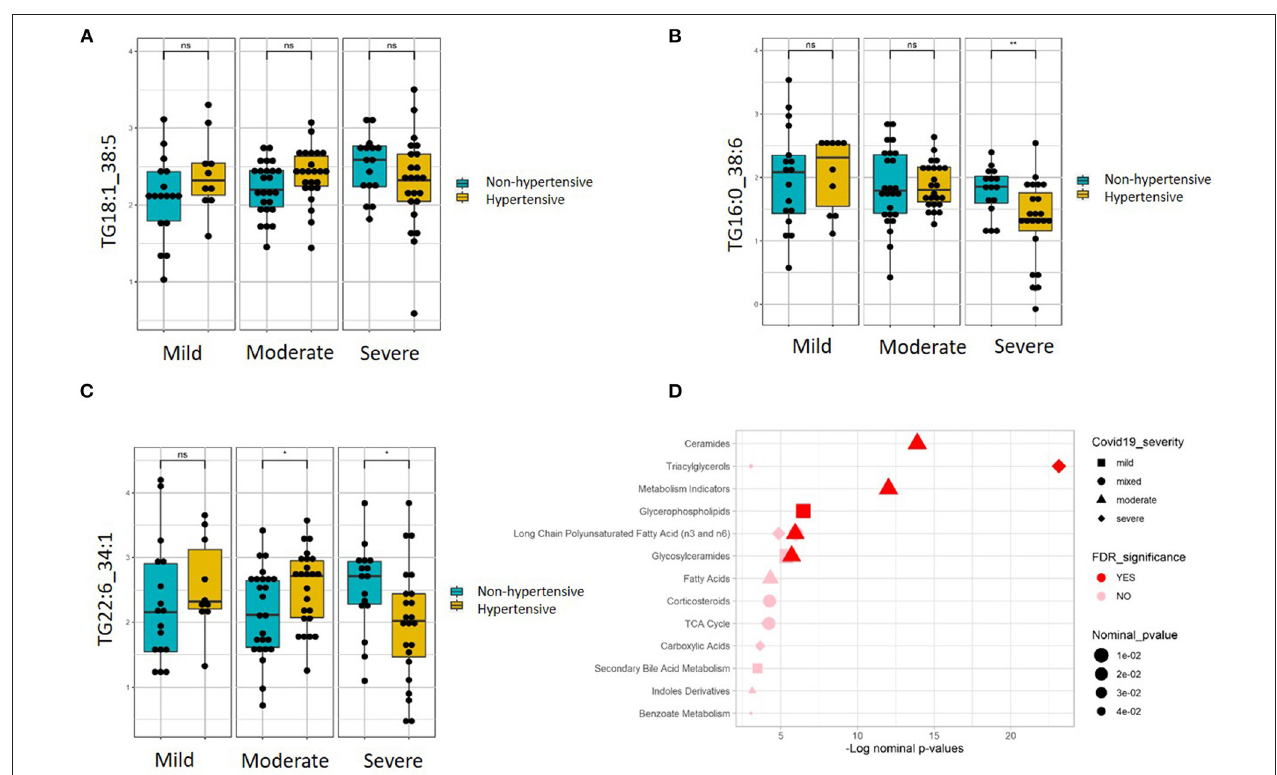
FIGURE 4 | Metabolites associated with COVID-19 severity levels in normotensive and hypertensive patients. Examples of metabolites containing (A) C16:0, (B) C18:1, and (C) C22:6, which show significantly different slopes between hypertensive and non-hypertensive patients from regressing the given metabolite on the ordinal COVID-19 severity levels (FDR < = 0.05). (D) Enriched metabolite classes in terms of COVID-19 disease severity. * p ≤ 0.05, ** p ≤ 0.01, ns, not